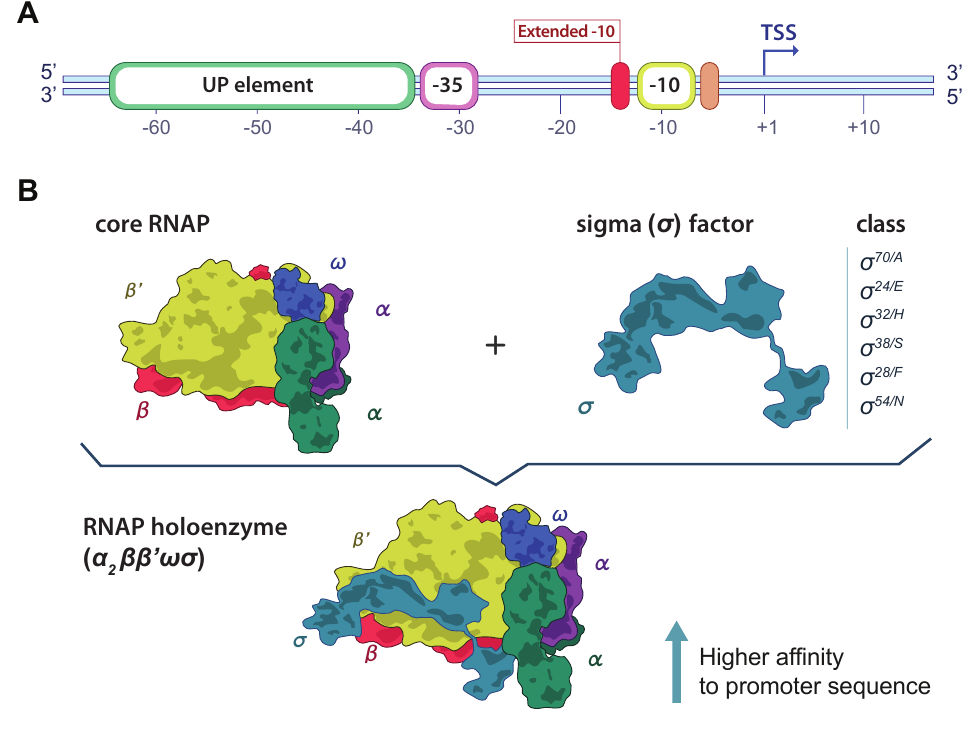
Figure 1. Graphic. representation of the bacterial DNA promoter and the RNA polymerase (RNAP) holoenzyme. ( A ) Key elements of the bacterial DNA promoter are crucial for RNAP affinity and binding. The coloured rounded rectangles represent key elements of the bacterial promoter. These include the UP element, the − 35 and − 10 hexamers, the extended − 10 element, and the discriminator sequence. The transcriptional start site (TSS) is represented at the +1 position. ( B ) The RNAP holoenzyme components and subunits. The two components of the functional RNAP complex are illustrated in the upper part: the core RNAP enzyme, composed of the α , β , and ω subunits; and the sigma ( σ ) factor, which improves the RNAP–DNA affinity for transcription. At the bottom, the binding of the σ factor to the core enzyme completes the RNAP holoenzyme ( α 2 ββ (cid:48) ωσ